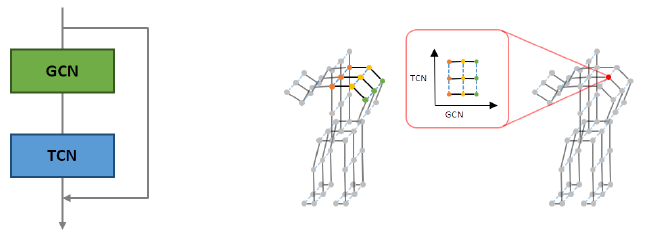
Figure 5. Depth of proposed ST ‐ GCN block: details of ST ‐ GCN ( left ) and spatial features of GCN and TCN ( right ).